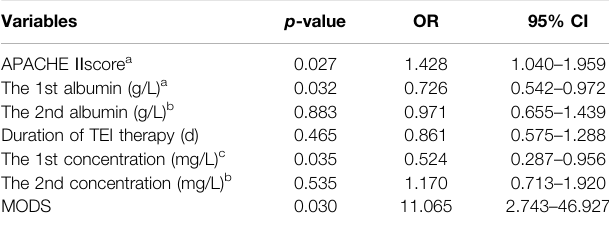
TABLE 4| Results ofriskfactors onclearanceofGram-positive bacteriascreened by multivariate logistic regression analysis. Variables p -value OR APACHE Ⅱ score a